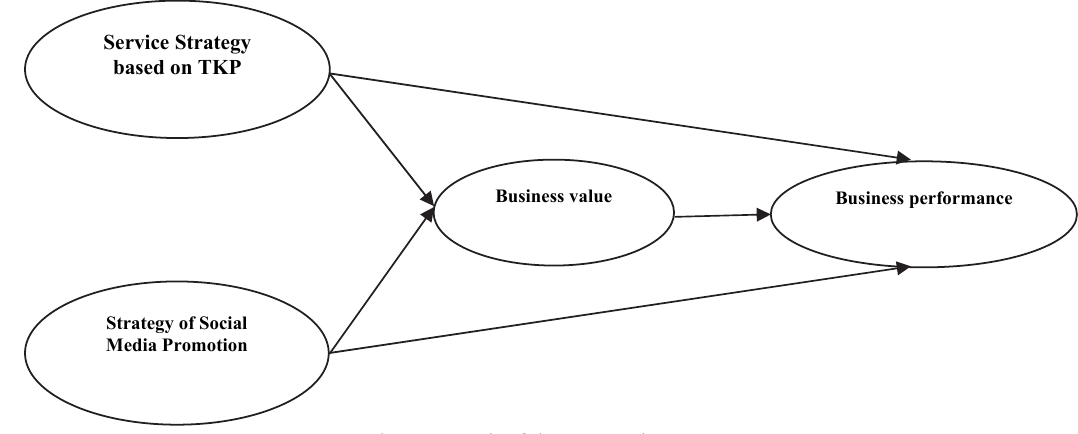
Fig. 1. Conceptual Framework of the